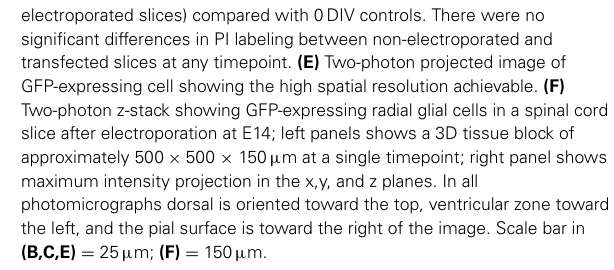
FIGURE 1 | Continued image of transfected spinal cord slice showing GFP expression (green) and SOX2 immunohistochemistry (red), dashed line represents the lumen (midline); the percentage of progenitor cells transfected (transfection efficiency) is calculated based on the number of SOX2 positive cells also expressing GFP on the transfected side (see inset for example). (D) Tissue viability was assessed at 0 (control) 2, 4, and 6DIV in electroporated and non-electroporated slices; PI labeling was used as a marker for cell death and expressed as a percentage of the total number of cells per slice. Percentage of PI labeling increased at 2DIV ( ∗ p = 0.0173 in non-electroporated slices) and decreased after 6DIV ( ∗ p = 0.0153 in non-electroporated; ∗ p = 0.023 in